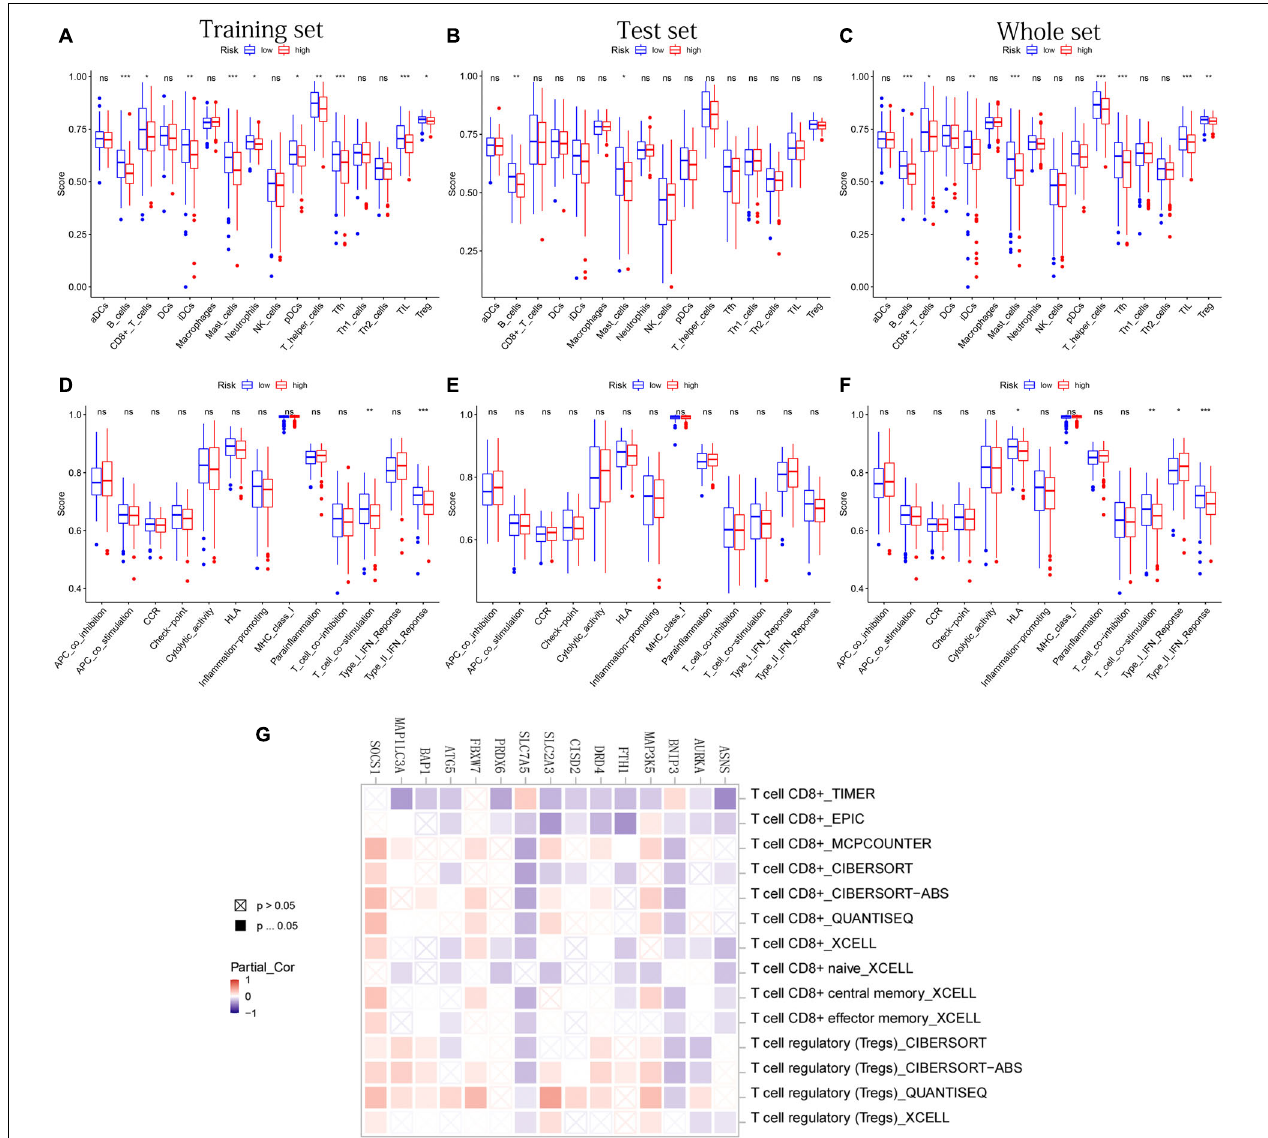
FIGURE 8 | The immune infiltrating cells/immune functions content associated with prognostic model. (A–C) The histograms, respectively, show the difference of the immune-infiltrating cells in the training, test, and whole sets, respectively. (D–F) The histograms, respectively, show the difference of the immune function in the training, test, and whole sets. The symbol above the histogram shows the significance of the difference. * p < 0.05; ** p < 0.01; *** p < 0.001; ns, no significance. (G) The correlation between the expression of 15 PR-DE-FRGs used to construct the model and CD8 + T